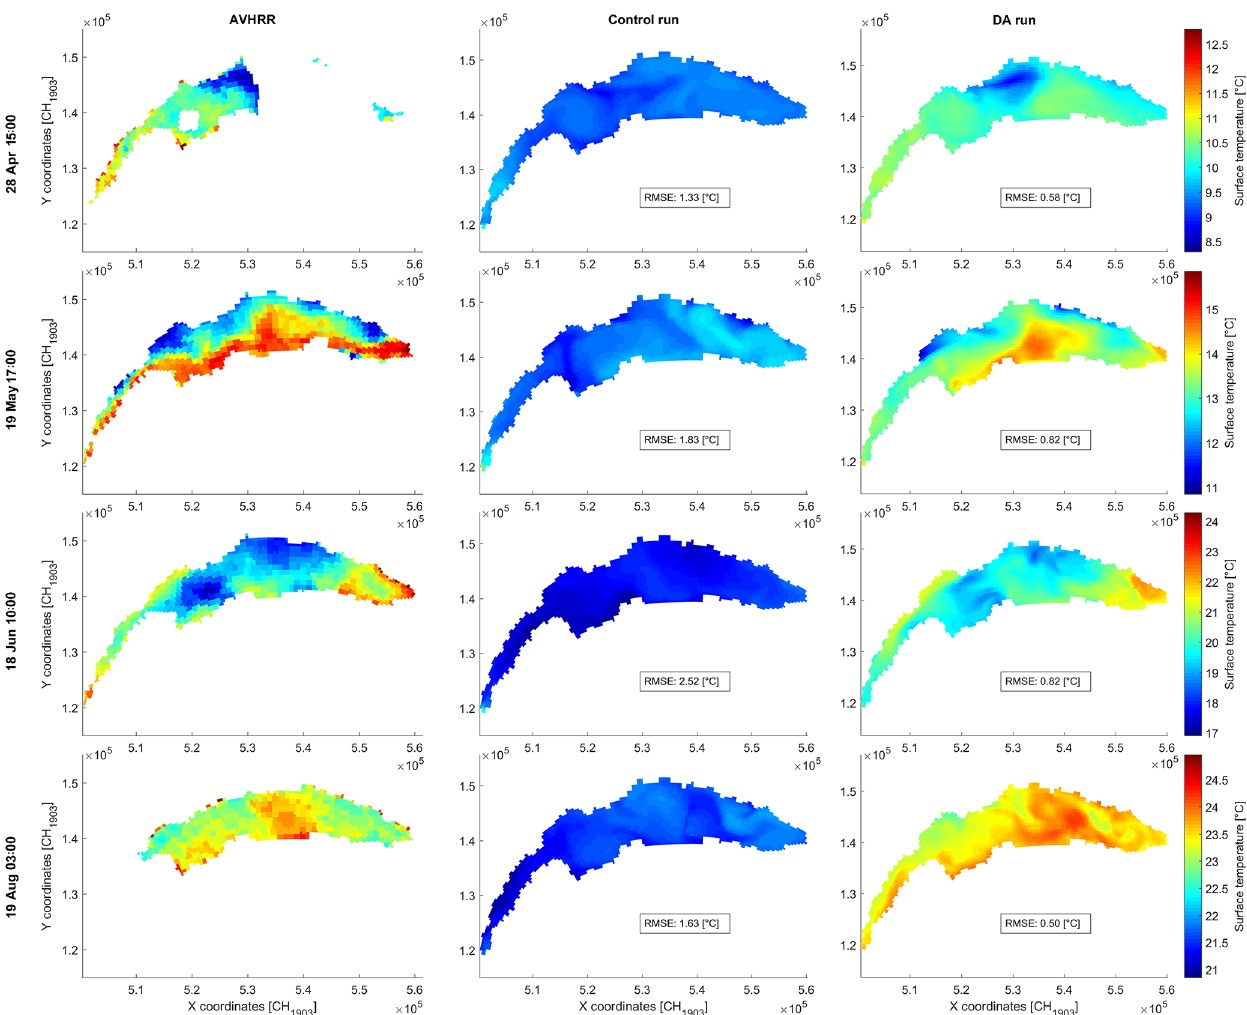
Figure B1. Surface temperature comparison of the AVHRR observations (left column), control run (central column), and DA run (right column) at selected analysis times (four rows) in 2017. The first row highlights the assimilation of sporadic data and the second row of complex surface patterns. The third row is an example of upwelling phenomena and the fourth row of gyre-like